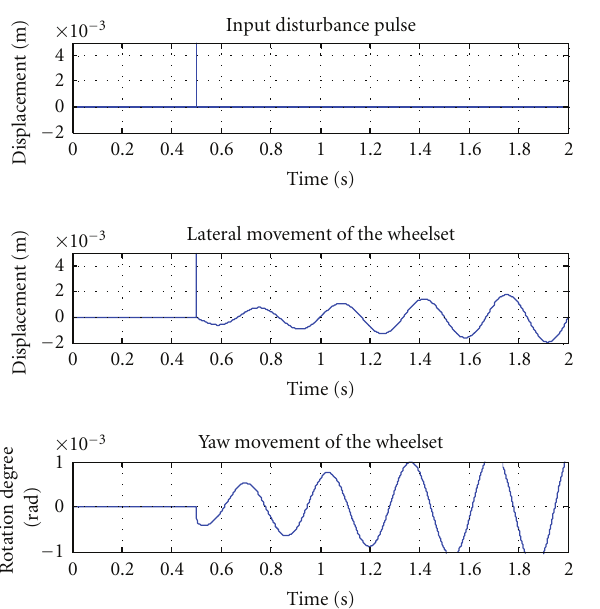
Figure 7: A wheelset without active motor control at 50m/s running speed.